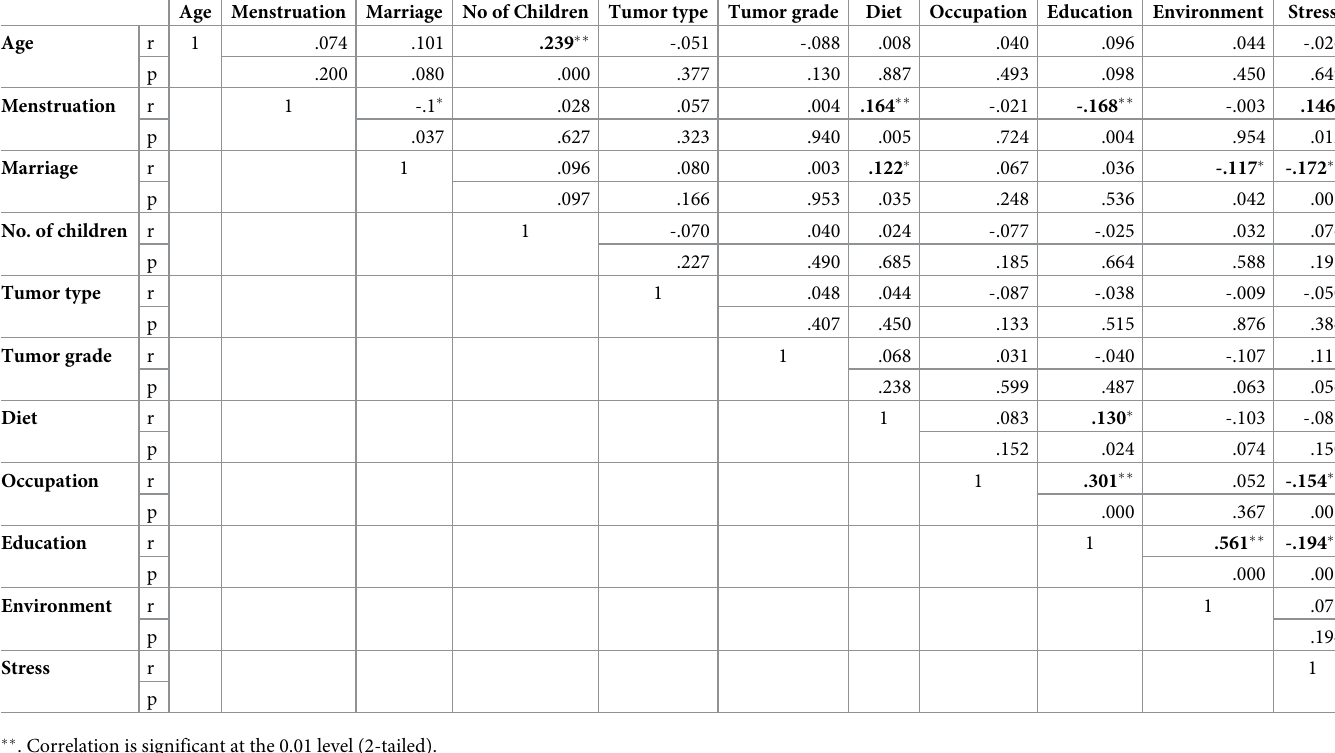
Table 2. Pearson correlation analysis of the relationship between different risk factors associated with breast cancer. Age Menstruation Marriage No of Children Tumor type Tumor